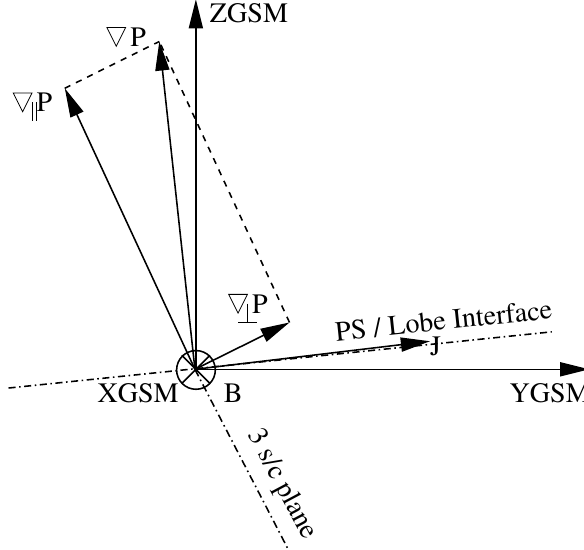
Fig. 7. Parallel, perpendicular, and total pressure gradient, together with the current density, J , and the magnetic field (into the page), B . The 3-spacecraft plane and the plasma sheet/lobe interface are shown as